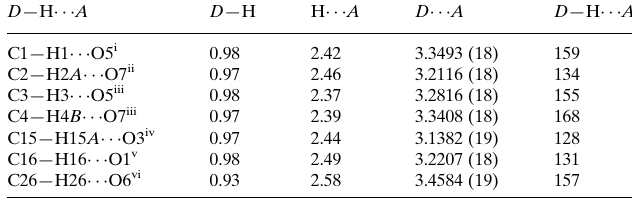
Hydrogen-bond geometry (A˚ , (cid:3)